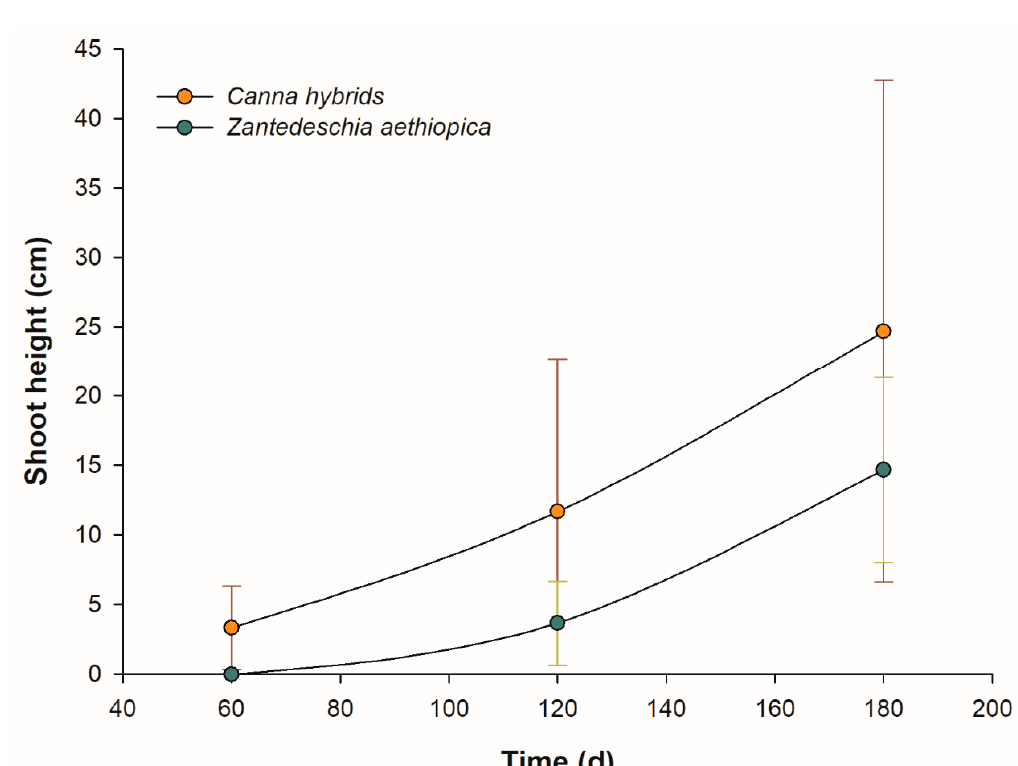
Figure 3. Growth of shoots.